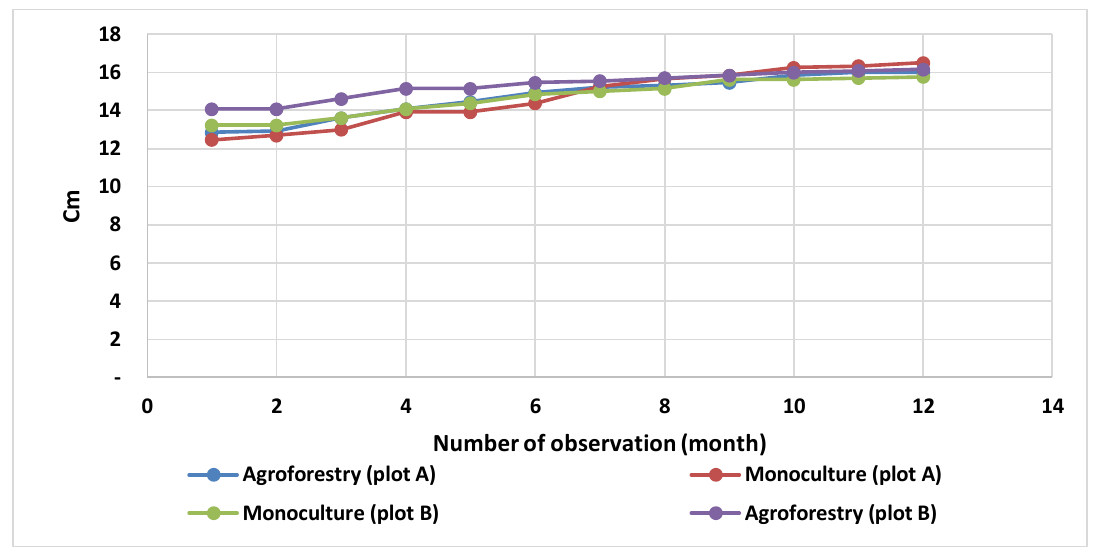
Figure 6. Height growth of kemiri sunan in monoculture vs. agroforestry plots in Buntoi reseaech site in Central Kalimantan.